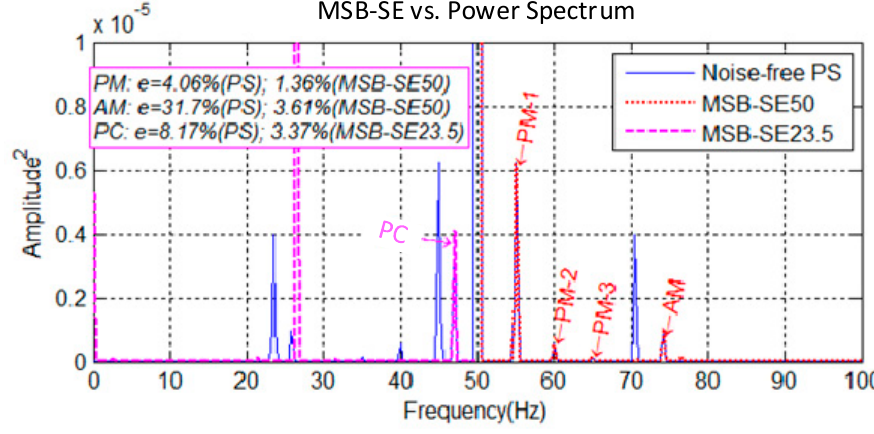
Figure 3. Performance of MSB estimator.